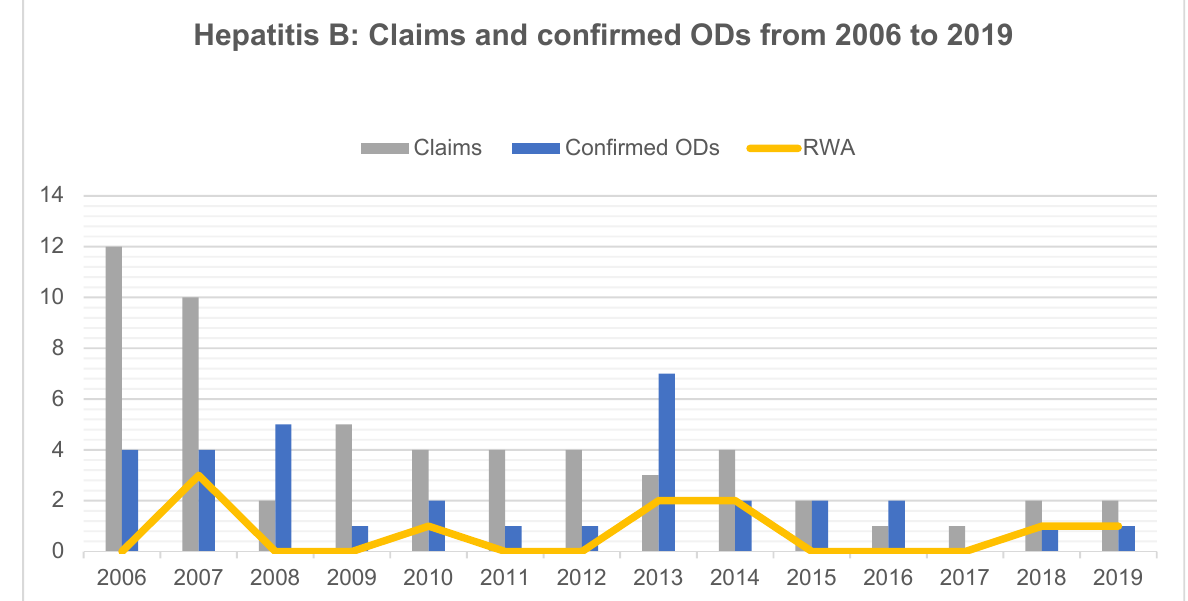
Figure 2. Hepatitis B virus infection: Number of claims, confirmed occupational diseases (ODs) and proportion of cases resulting in a reduced working ability (RWA) among dental health workers from 2006 to 2019.